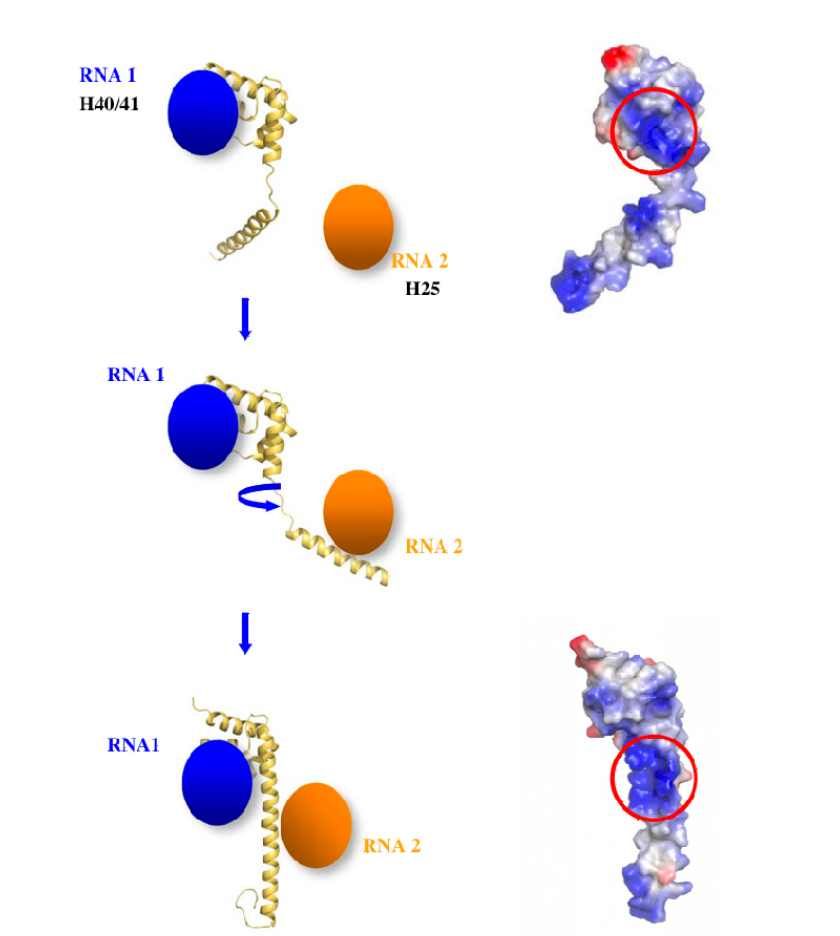
Figure 8. Fishing mechanism that can help to bring into proximity RNA segments coming from different rRNA domains. The two forms of L20 display very different electrostatic surface potential and affinity for RNA (top: partially unfolded, bottom: